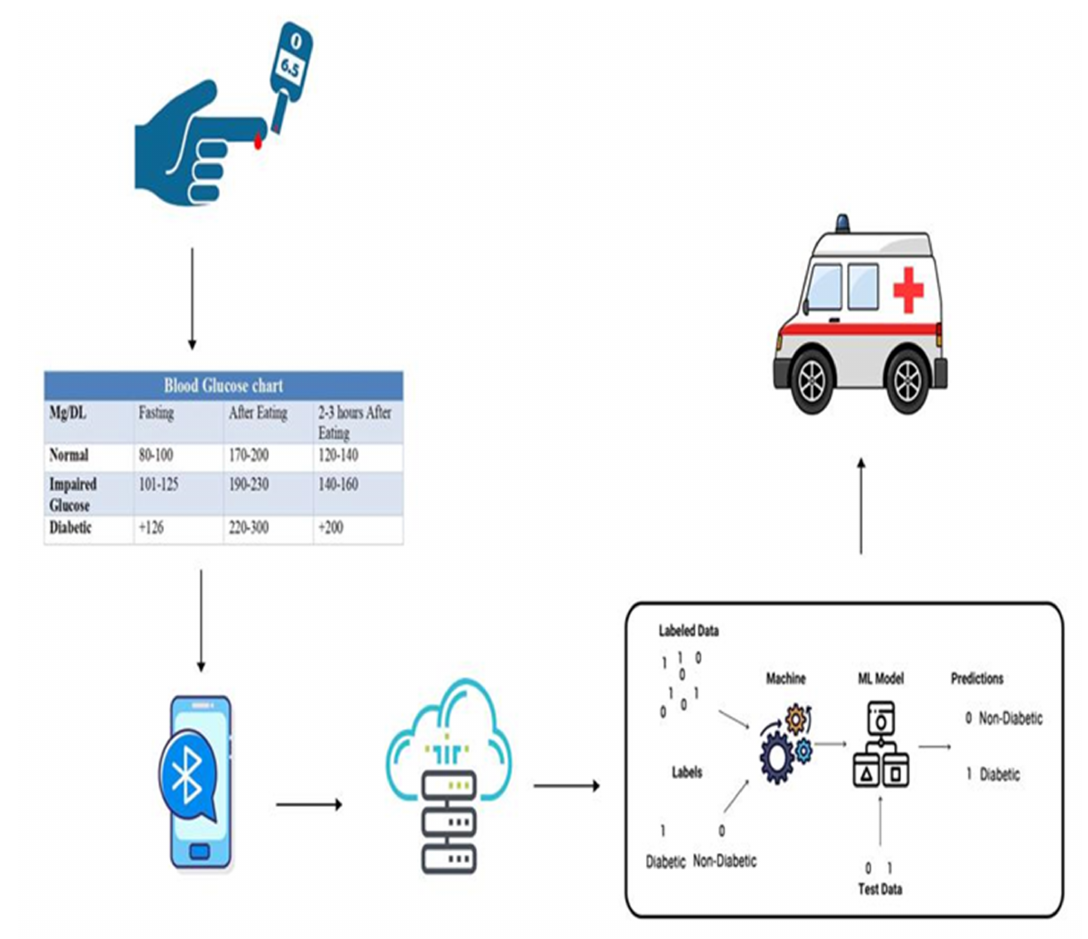
Figure 3. Cloud computing architecture related to diabetes